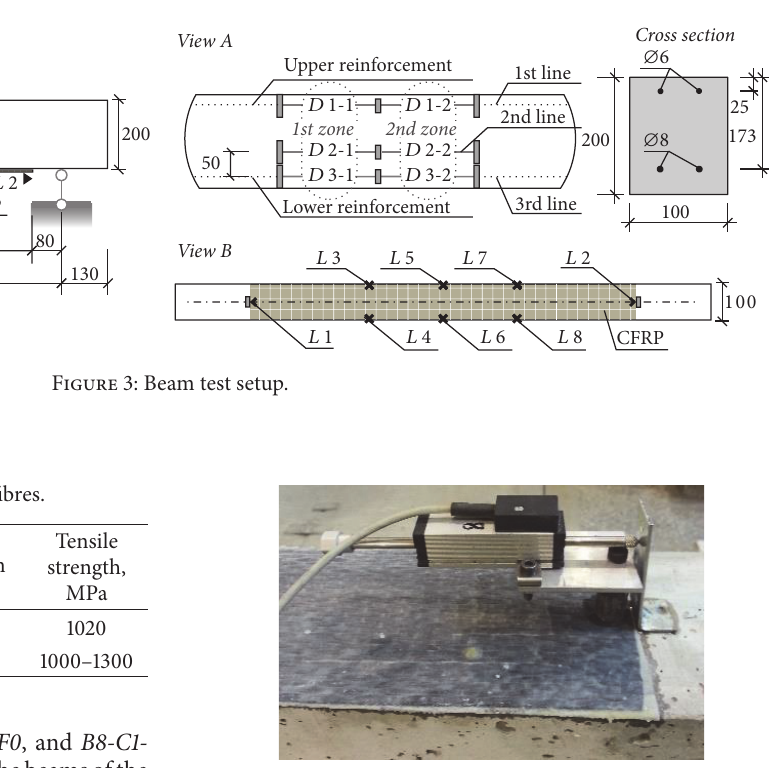
Figure 4: Slip measurement of the CFRP